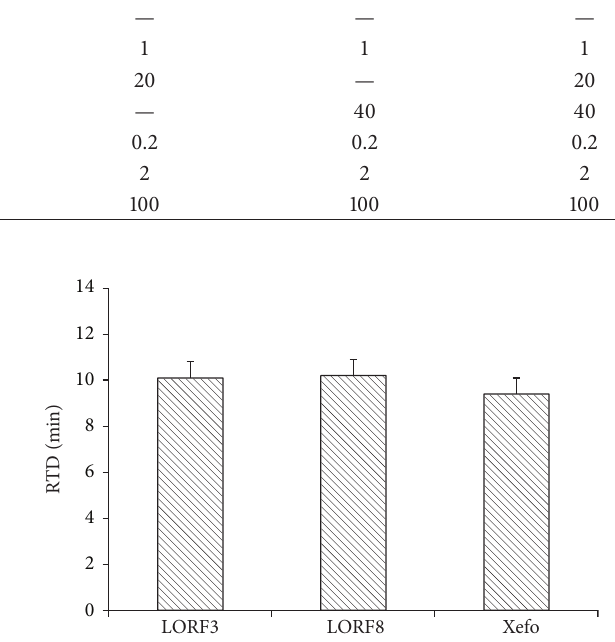
Figure 6: Analgesic effect of LOR gel formulation and Xefo with respect to RTD after 180